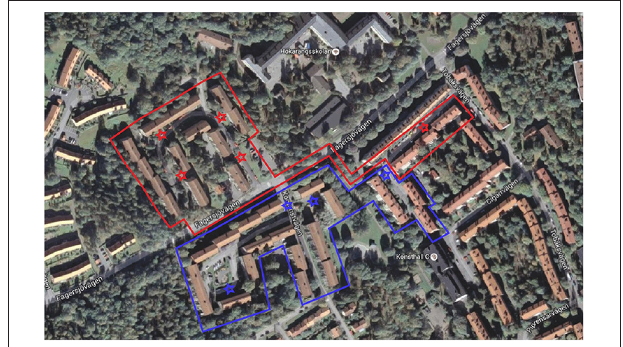
FIGURE 2 | Satellite picture of the research area. The blue area represents the treatment group, all the houses within that area got the information leaflet delivered to them. The red area represents the control group which got no information. The red and blue stars show where the sorting stations are located. Source: Google,